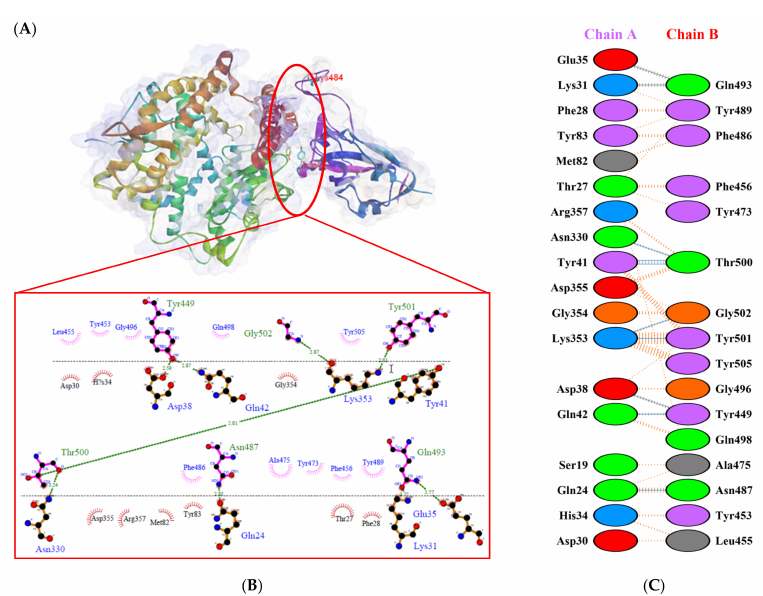
Figure 4. Protein–protein docking representation of hACE2 and RBD Gamma complexes. ( A ) The complex’s binding interface; ( B ) The amino acid’s binding interaction; and ( C ) The interaction representation, which includes hydrogen ( ), salt bridges ( ), and non-bonded ( ) interactions. Chain A represents hACE2 and chain B represents RBD Gamma. Residue colors: positive (blue): H,K,R; negative (red): D,E; neutral (green): S,T,N,Q; aliphatic (grey): A,V,L,I,M; aromatic (purple): F,Y,W; Pro & Gly (orange):